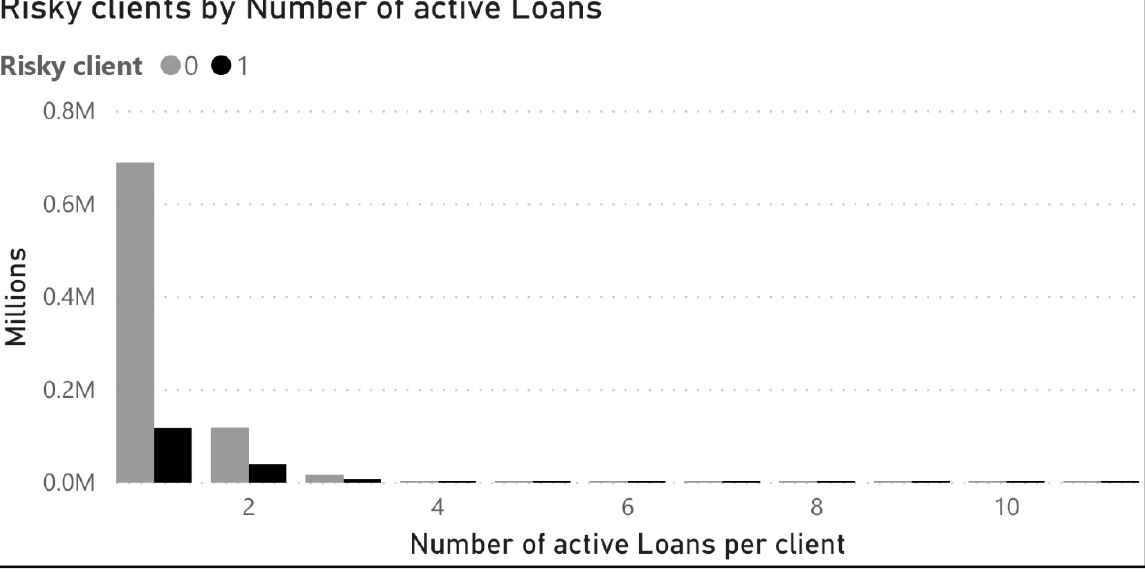
Figure 6. Risky borrowers by number of active loans. The figure shows the distribution of loans by the number of active loans per borrower.